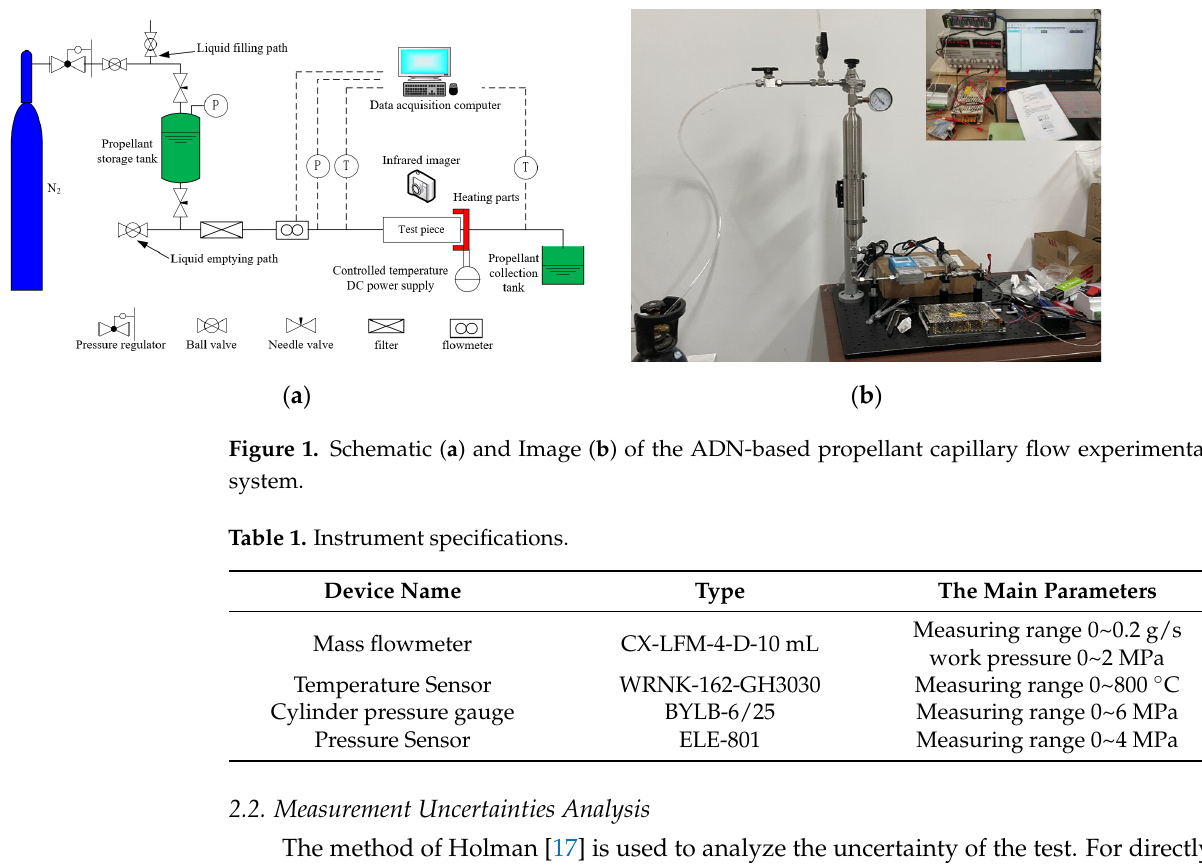
Table 1. Instrument specifications.